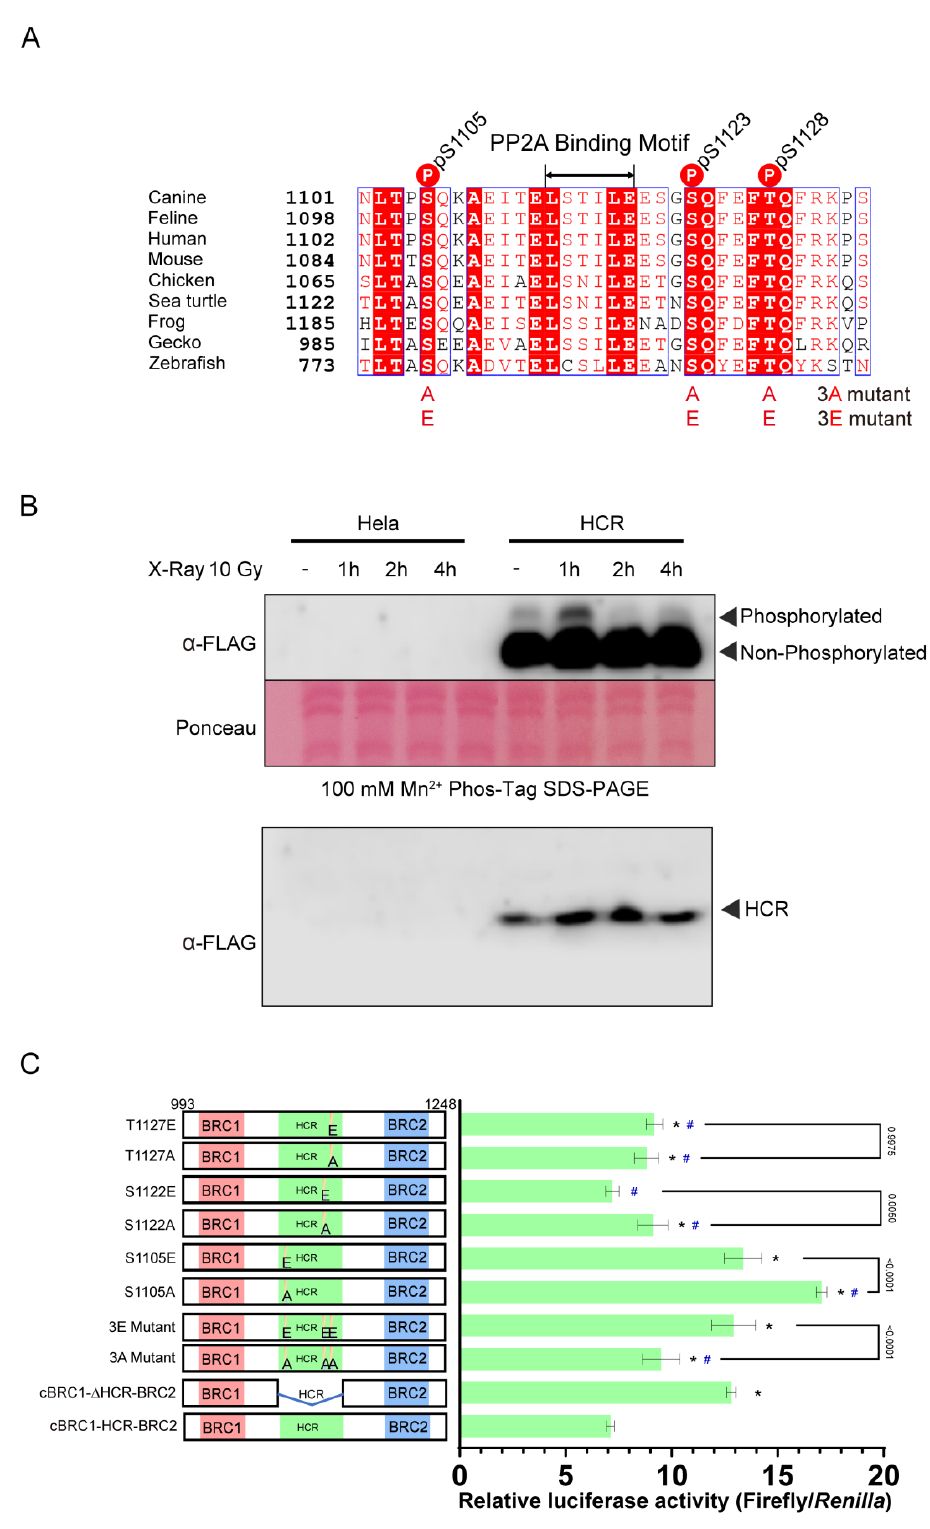
Figure 4. Phosphorylation of the highly conserved region (HCR) probably mediates the interaction between BRC repeats and RAD51. ( A ) Alignment of the HCR. Canine, feline, human, mouse, chicken, sea turtle, frog, gecko, and zebrafish HCRs in BRCA2 were aligned. Identical residues are shown in red background; the conservative substitutions are grouped by blue boxes; red letters indicate similar residues according to the Risler matrix, and the remainder were shown in black [26]. The sites of